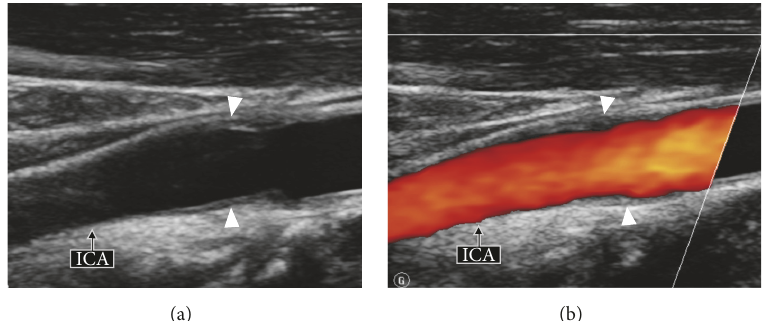
Figure 2: US longitudinal view (a) and corresponding color Doppler image (b) obtained 4 months later show regression of the fusiform wall thickening (arrowheads) of the left carotid bulb. ICA: internal carotid artery. See for comparison Figures 1(b) and 1(c) obtained 4 months